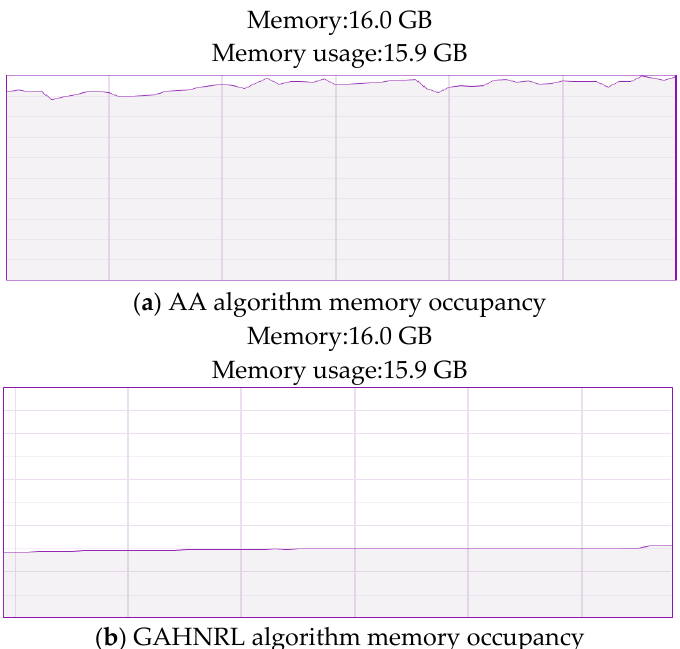
Figure 7. Memory usage of AA and GAHNPL algorithms.